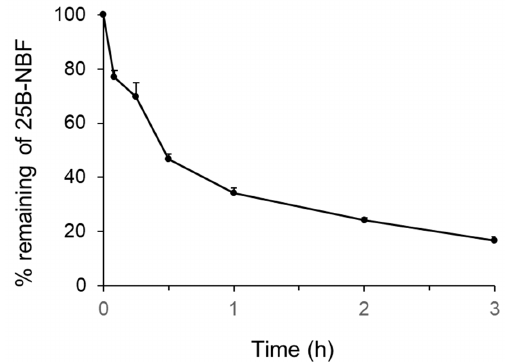
Figure 1. Percentage of 25B-NBF [2-(4-bromo-2,5-dimethoxyphenyl)- N -(2-fluorobenzyl)ethanamine] remaining after incubation with human hepatocytes at 37 ◦ C in a CO 2 incubator. The symbol and error bar represent mean and standard deviation, respectively ( n =